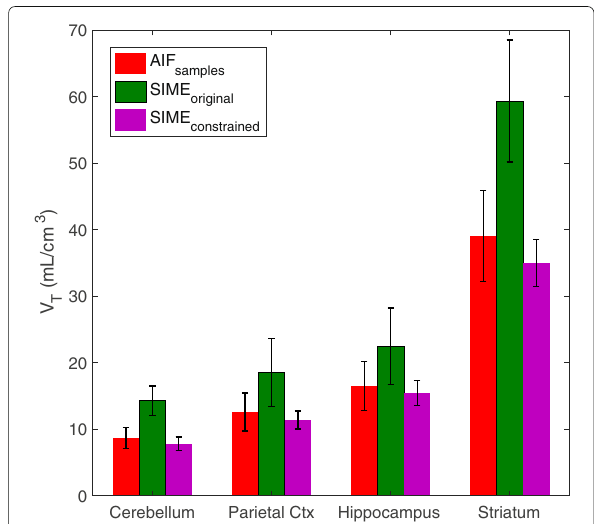
Fig. 6 V T estimated for four brain regions using the AIFs estimated from AIF samples , SIME original and SIME constrained . The bars represent the V T values estimated across 10 studies and error bars represent the standard deviation